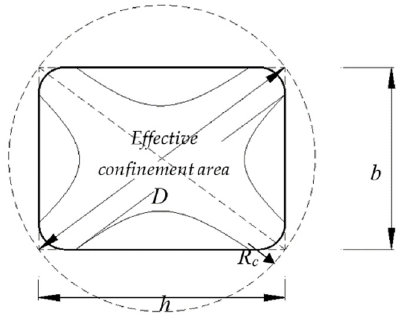
Figure 17. Equivalent circular cross section.